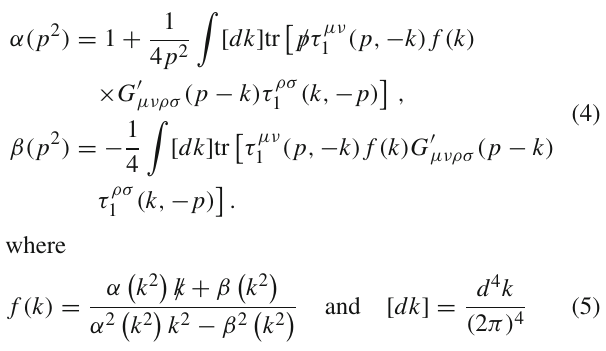
Fig. 1 The self-energy correction to the neutrino propagator. The graviton (represented by the double wavy line) is dressed with the vacuum polarisation (indicated by Π ) and external arrows show the momentum flow ing them into Eq. (3), α( p 2 ) and β( p 2 ) may be written